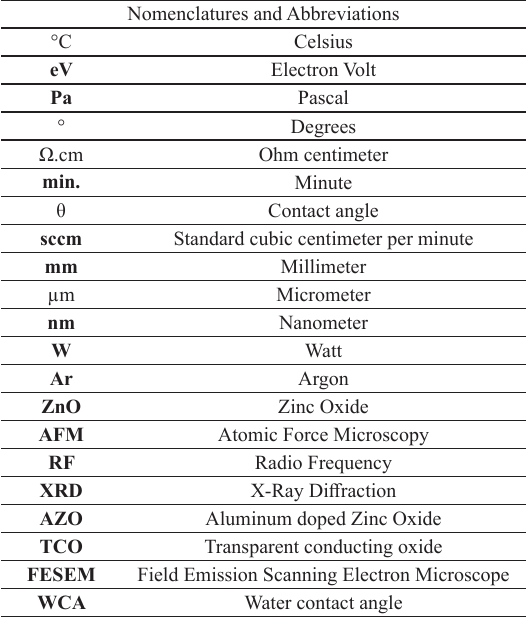
Table 3. Nomenclatures and